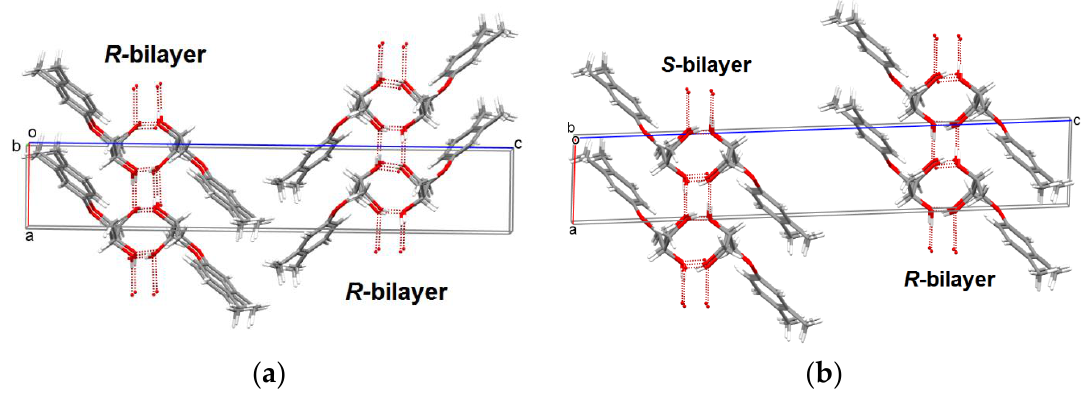
Figure 9. Stacking of H-bonded homochiral bilayers in ( R )- 1 ( a ) and α - rac - 1 ( b )